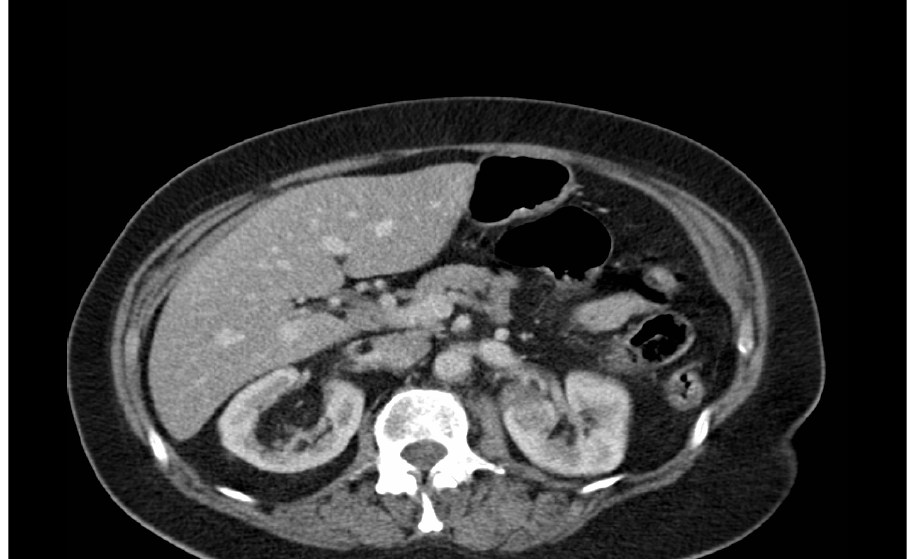
FIGURE 2 . CT of a soft tissue mass seen in the left